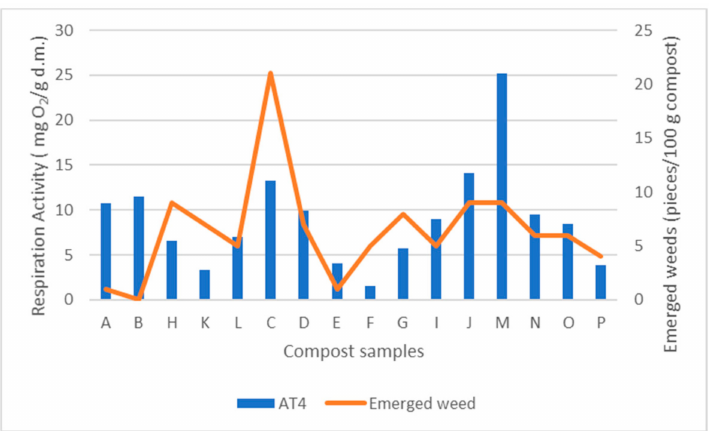
Figure 1. The determined respiration activity (AT4) and the number of weeds that emerged within 14